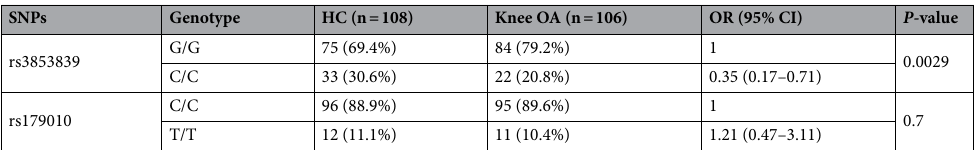
Table 5. Association analysis between SNPs and the male Knee OA risk. Knee OA osteoarthritis patients group, HC healthy control group, OR odds ratios, CI confidence intervals; The data adjusted by smoke + drinking + age +